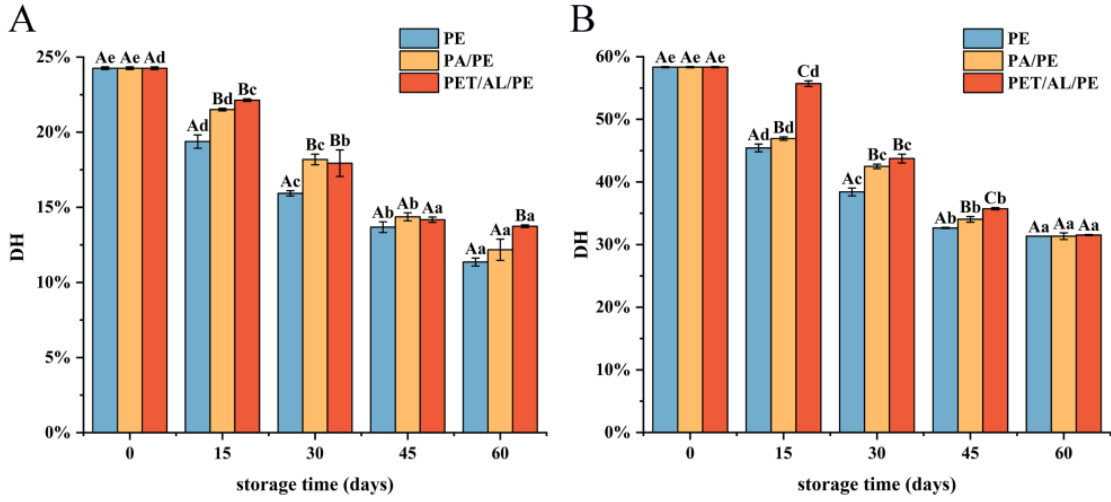
Figure 8. Effect of storage conditions on gastrointestinal digestibility of walnut protein isolate (( A ) degree of hydrolysis after 2 h of gastric digestion; ( B ) Degree of hydrolysis after 2 h intestinal diges- tion). In the figure, capital letters represent the differences among package materials in each storage period, lower letters show differences among storage periods in each package at p < 0.05 error level according to Duncan ’ s multiple range test. The error bar represents the standard error of the mean value.